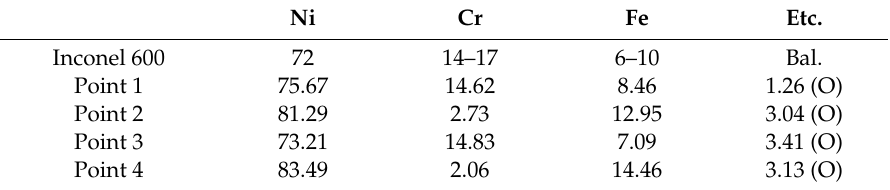
Table 2. Quantitative energy dispersive spectroscopy (EDS) results from 4 points in Figure 1 (wt.%). Ni